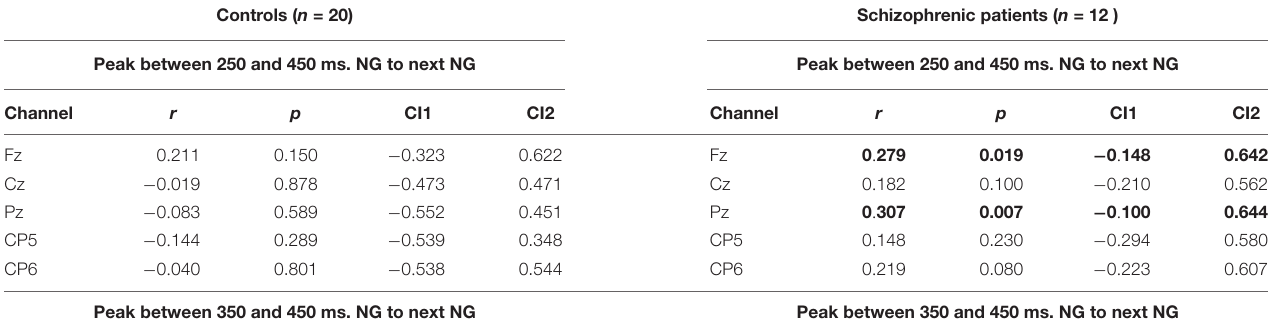
TABLE 3 | Correlations between peak amplitude in EEG channels Fz, Cz, Pz, CP5, and CP6 and time between Novels. Controls ( n = 20) Schizophrenic patients ( n = 12 ) Peak between 250 and 450 ms. NG to next NG Peak between 250 and 450 ms. NG to next